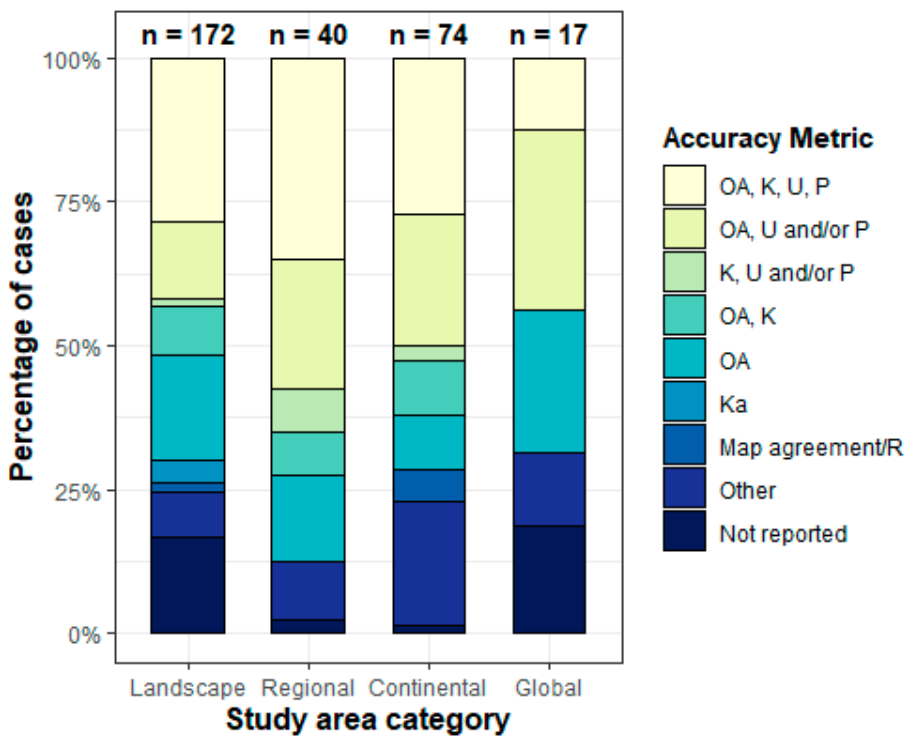
Figure 3. Type of accuracy assessment metrics reported at the different scales category. OA = overall accuracy, K = kappa, U = user’s accuracy, P = producer’s accuracy, R = correlation, Ka = allocation